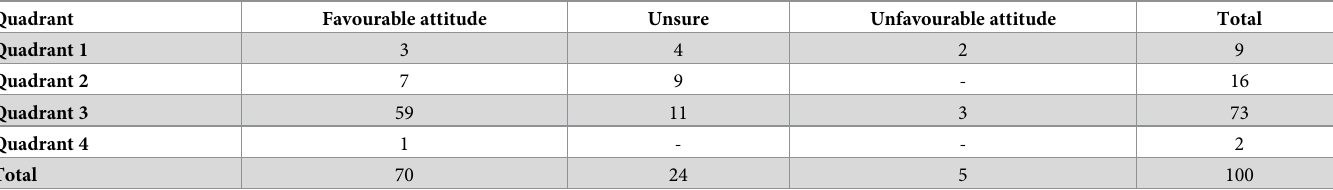
Table 2. I 3 mapping for wearing face masks.